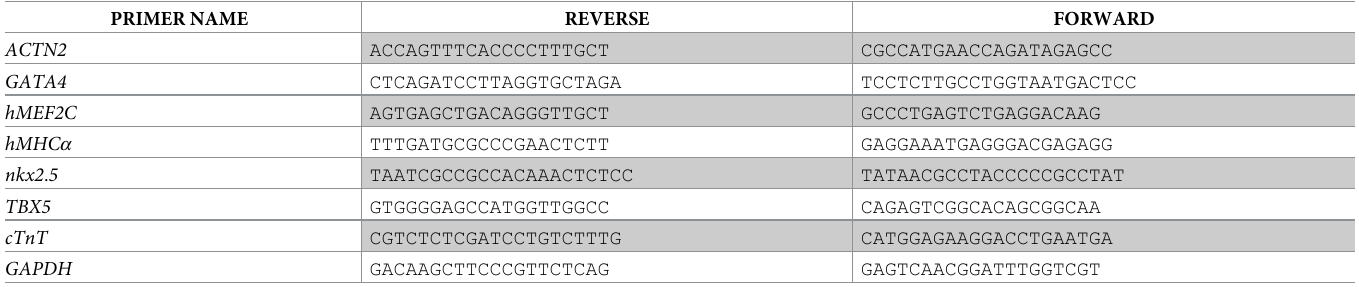
Table 1. Primers used in this